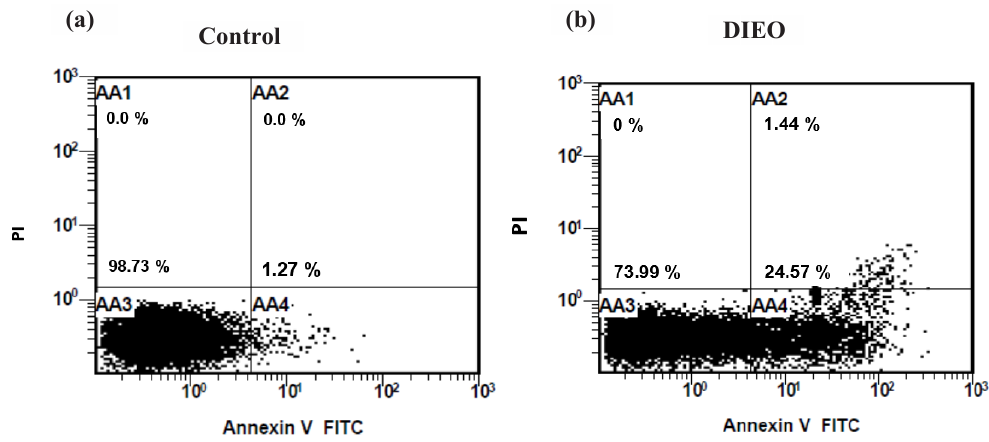
Figure 4: Apoptosis detection using flow cytometry after annexin V-FITC/propidium iodide (PI) staining for (a) Control and (b) DIEO. Viable cells are in the lower left quadrant (AA3); early apoptotic cells are in the lower right quadrant (AA4); late apoptotic cells are in the upper right quadrant (AA2); and non-viable necrotic cells are in the upper left quadrant (AA1). Table 3: Antimicrobial activity of the D. ismaelis essential oil (DIEO) (mg/mL). Microorganisms Activity DIEO Gentamycin Nystatin Bacteria S. aureus